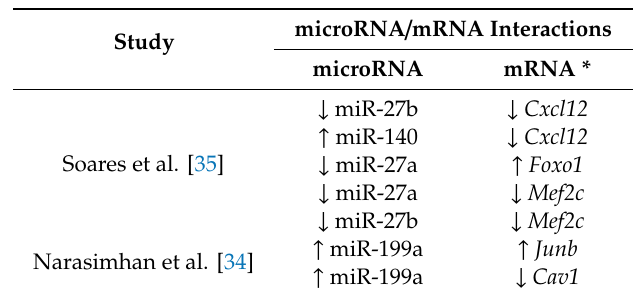
Figure 5. MicroRNAs and mRNAs identified in muscle wasting in cancer cachexia. ( A ) MicroRNAs predicted in silico as targeting mRNAs retrieved by our meta-analysis (pink circle) were further compared with microRNAs identified as differentially expressed in previous studies of muscle wasting in cancer cachexia, performed by Soares et al. [35] (yellow circle) and Narasimhan et al. [34] (blue circle). ( B ) Venn Diagram comparing the predicted microRNA target for Soares et al. [35] (red circle) and Narasimhan et al. [34] (green circle) with the list of 52 deregulated genes in muscle wasting in cancer cachexia identified in our meta-analysis (purple circle). Identification of new relevant microRNA–mRNA interaction in muscle wasting in cancer